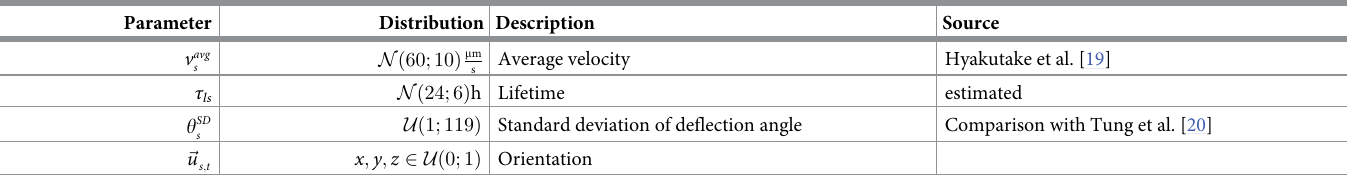
Table 1. Major sperm parameters and their origin. Speed and lifetime were drawn from normal distributions N . The standard deviation of the deflection angle and the initial orientation were obtained from uniform distributions U . Parameter